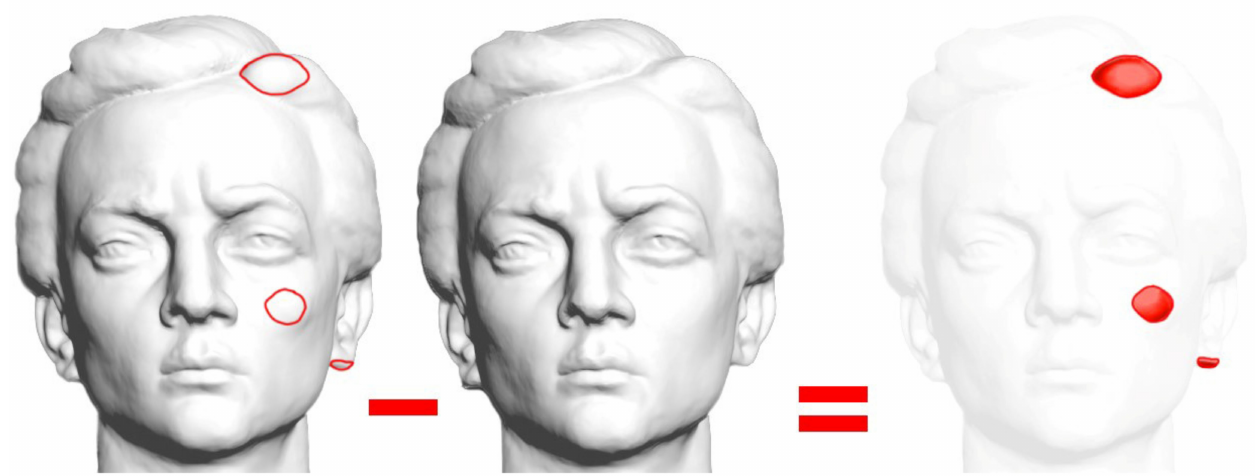
Figure 18. Digital protection extraction using 3ds Max software as a subtraction between the protected and the original 3D